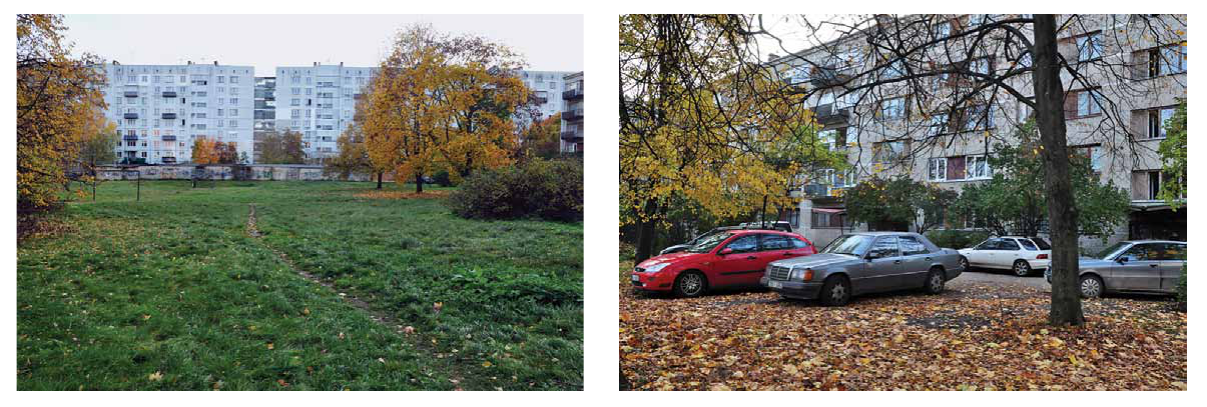
Fig. 1. Existing characteristic green open space in large-scale housing area